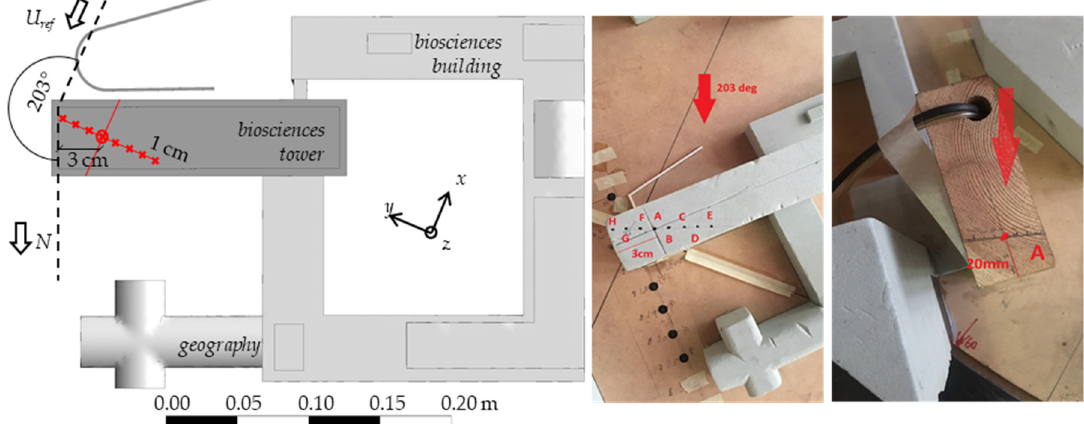
Figure 2. Wind tunnel measurements and position of wind profiles on top of the roof of